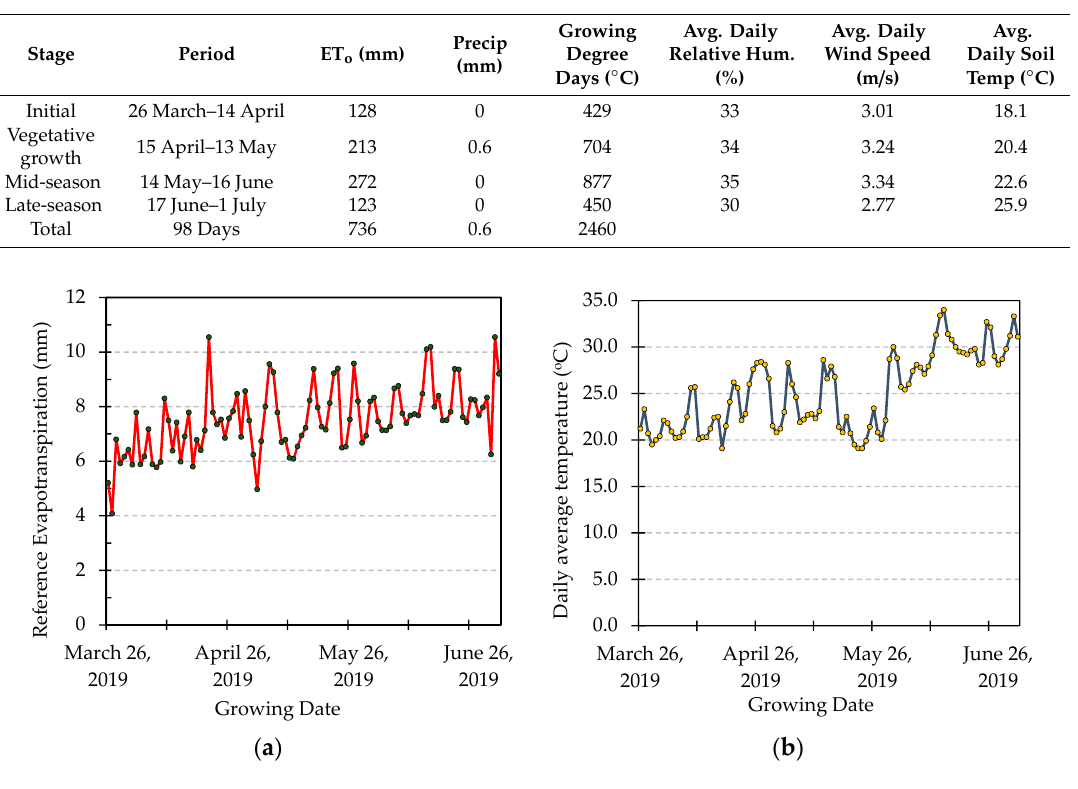
Figure 2. ( a ) Daily (reference evapotranspiration—ET o ) (mm) and ( b ) daily average temperature (°C) during the growing season.